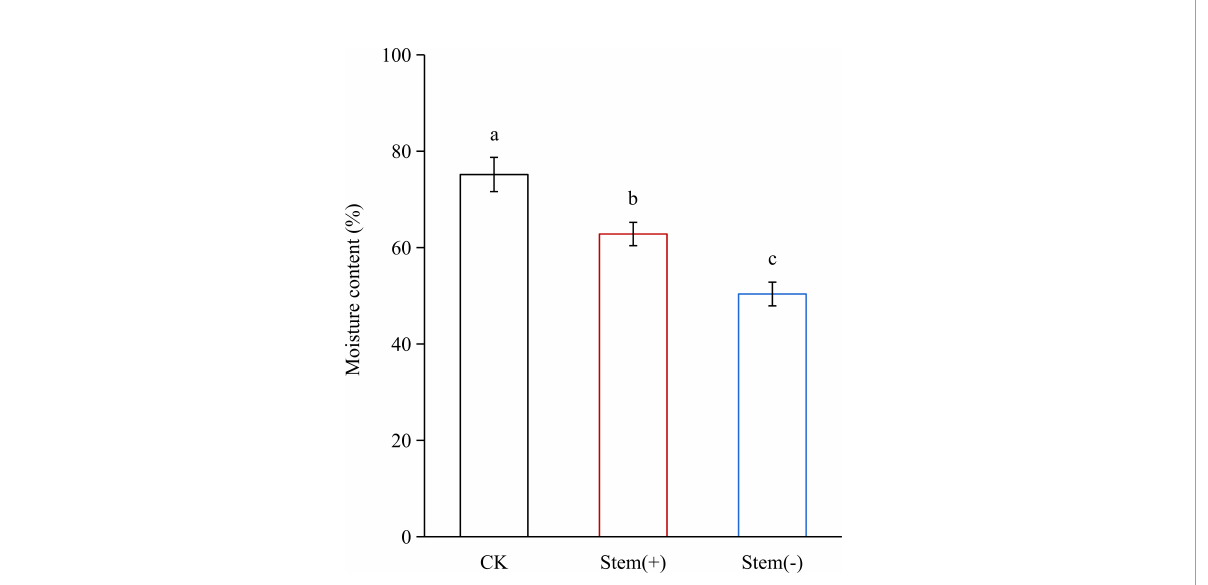
FIGURE 3 Effect of stem on leaf moisture content in fl ue-cured tobacco leaves. Different letters indicate statistically signi fi cant difference at p < 0.05, as determined by